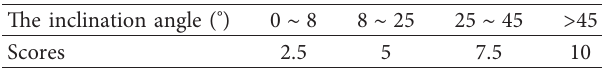
Table 5: The scores of the inclination angles.